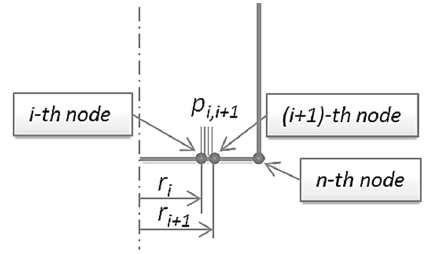
Figure 8. Scheme of the 2D FEM model of the pin.